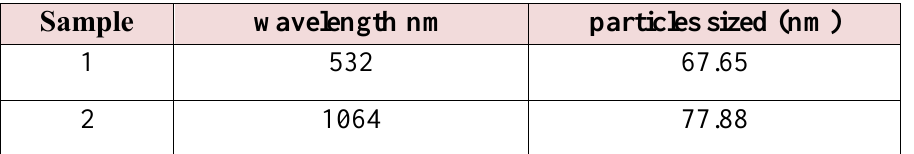
Table 1. Process of synthesis Fe@Au